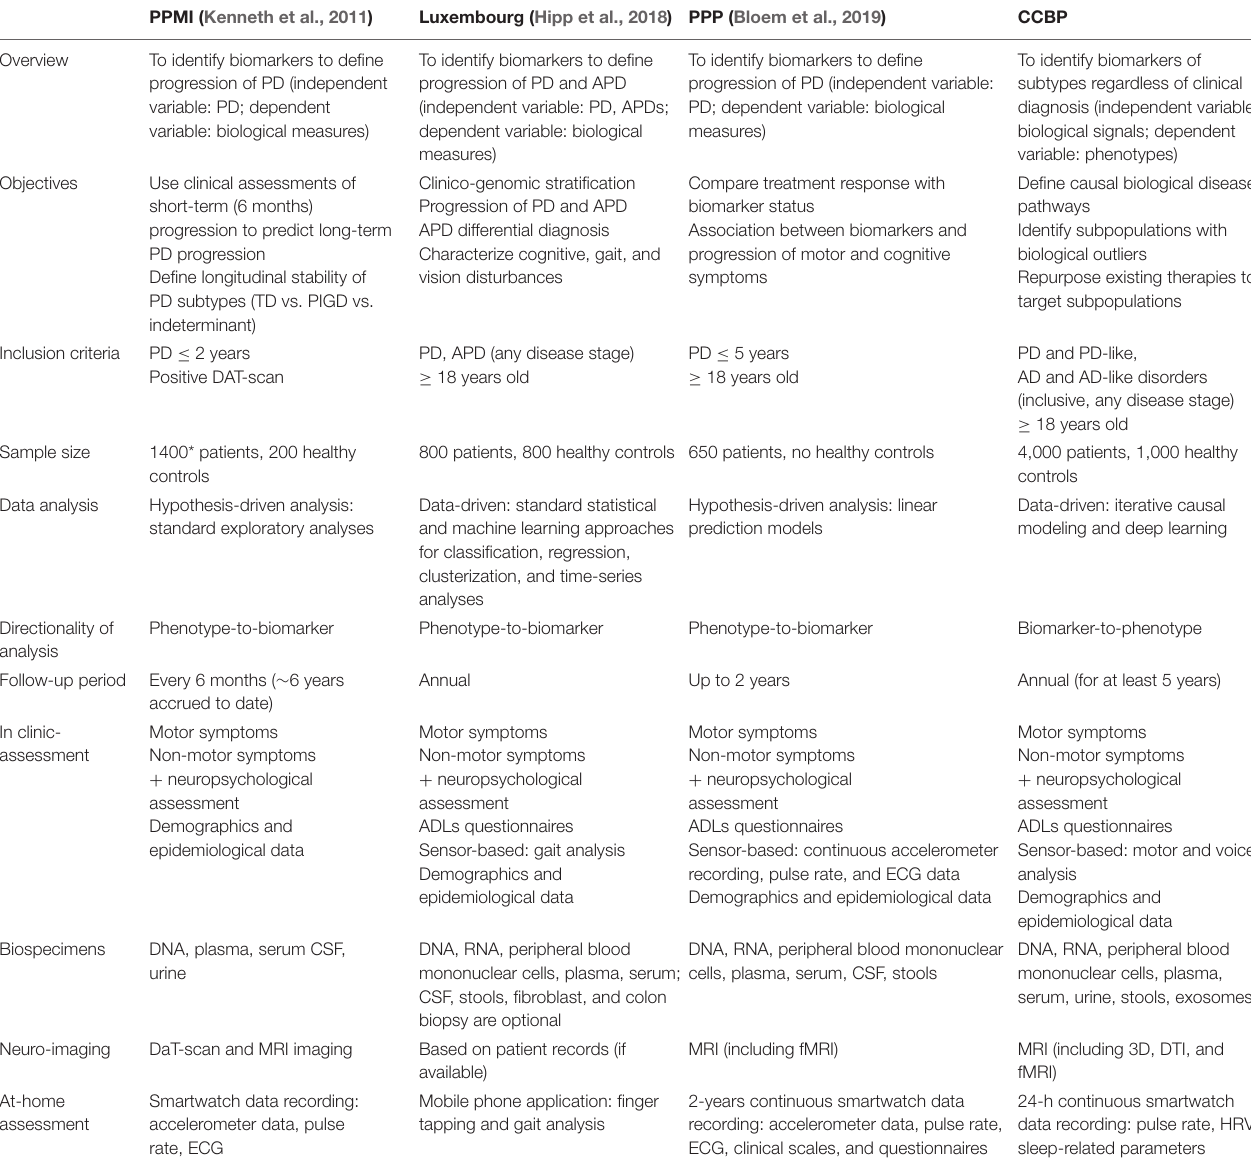
TABLE 1 | Comparison between established biomarker-development cohorts. PPMI (Kenneth et al.,